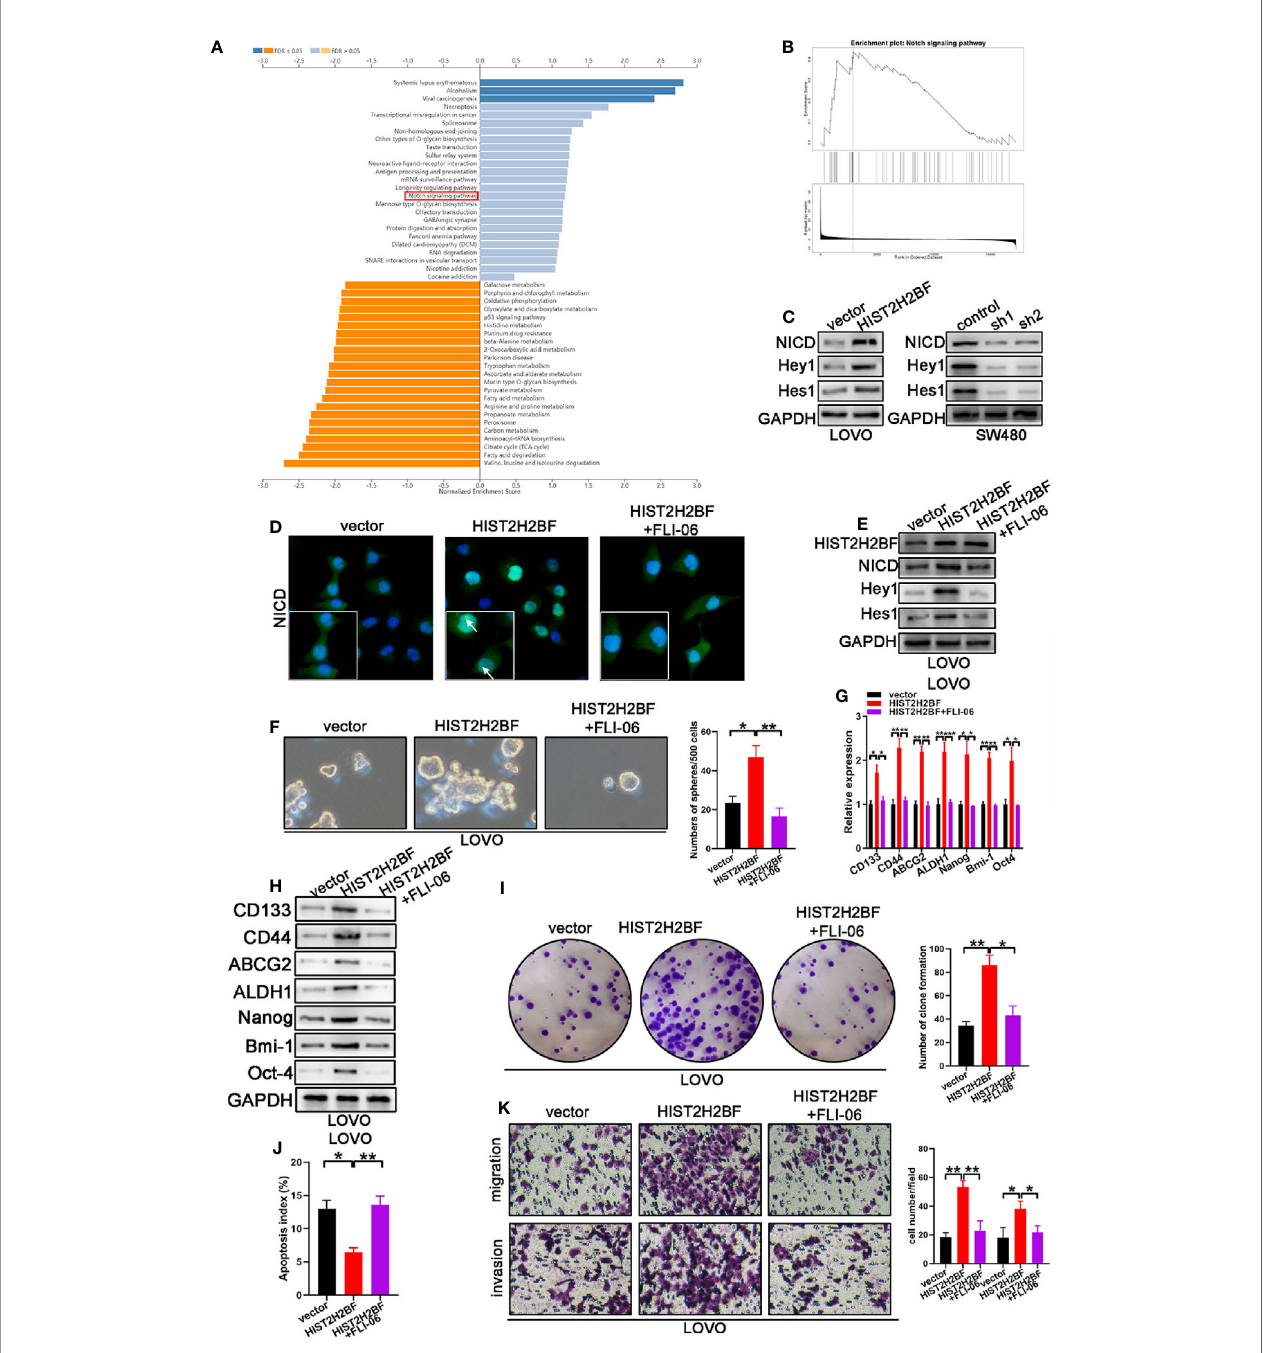
FIGURE 6 | HIST2H2BF activates Notch signaling to promote the development of stem cell-like and cancer properties in CRC. (A) Kyoto Encyclopedia of Genes and Genomes (KEGG) analysis was performed via LinkedOmics. (B) Notch signaling is regulated by HIST2H2BF. (C) Western blotting indicated NICD, Hey1, and Hes1 expression in LOVO and SW480 cells infected with lentivirus HIST2H2BF or shHIST2H2BF. (D) Fluorescence microscopy analysis for NICD in LOVO cells. Arrowheads indicate the expression of NICD in the nucleus. Green, NICD; blue, nucleus. (E) Following FLI-06 treatment, Western blotting indicated NICD, Hey1, and Hes1 expression in LOVO cells infected with lentivirus HIST2H2BF. (F) Following FLI-06 treatment, the spheres were counted in LOVO cells infected with lentivirus HIST2H2BF. (G) Following FLI-06 treatment, the expression CSC-related biomarkers were detected in LOVO cells infected with lentivirus HIST2H2BF using real-time PCR. (H) Following FLI-06 treatment, the expression CSC-related biomarkers were detected in LOVO cells infected with lentivirus HIST2H2BF using Western blotting. (I) Following FLI-06 treatment, colony formation assays were carried out in LOVO cells infected with lentivirus HIST2H2BF. (J) Following FLI-06 treatment, apoptosis assays were carried out in LOVO cells infected with lentivirus HIST2H2BF. (K) Following FLI-06 treatment, migration and invasion assays were carried out in LOVO cells infected with lentivirus HIST2H2BF. *P < 0.05, **P < 0.01, ***P <